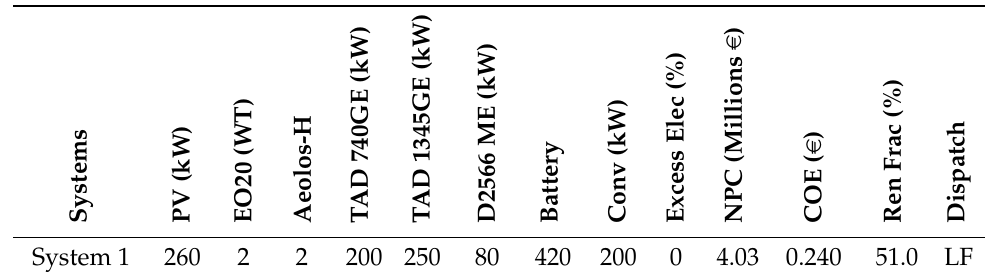
Table 14. Scenario 2 Optimization